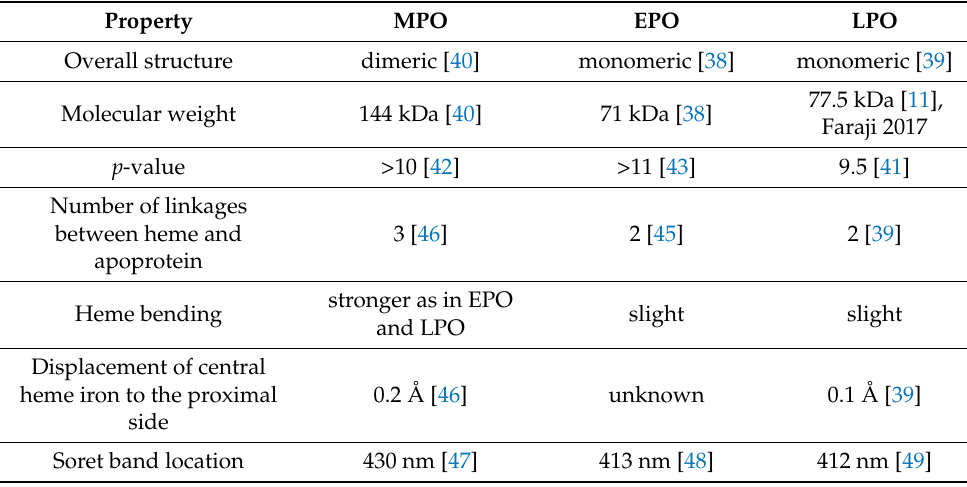
Table 1. Selected structural properties of heme